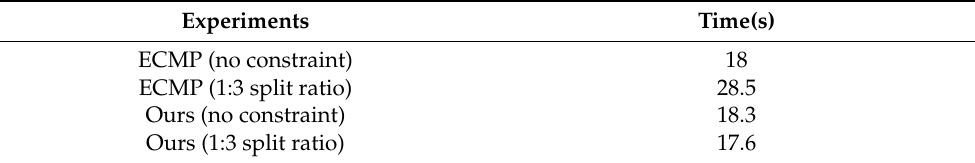
Figure 9. Results of the influence of the load balancing schema. Table 2. Comparison of the transfer time between ECMP and our